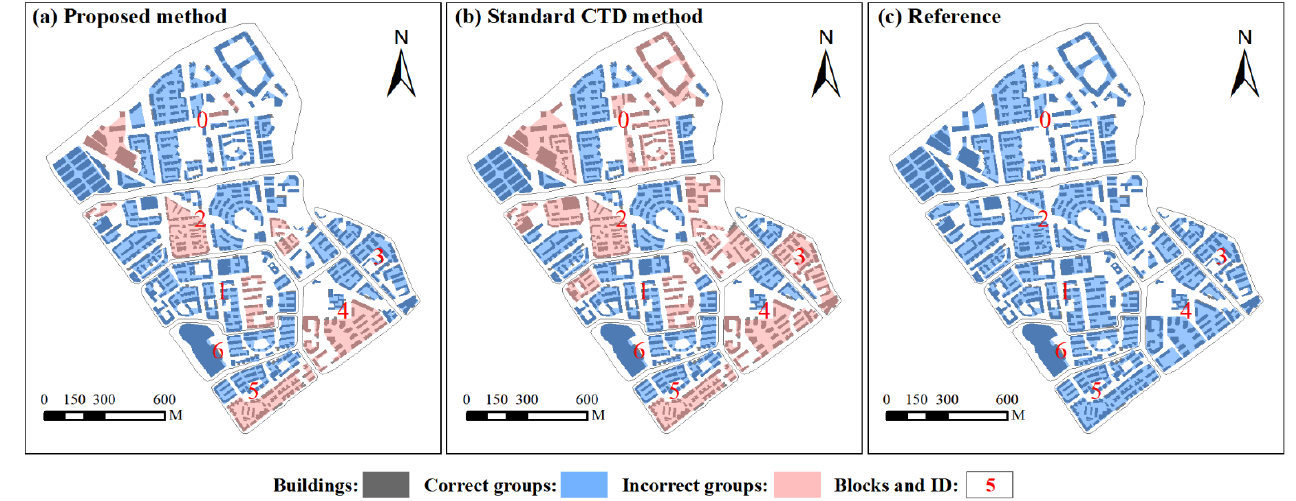
Figure 5. Building group recognition results are shown for ( a ) the proposed method, ( b ) the standard CTD method, and ( c ) the reference map. Buildings covered with blue hatched patterns were correctly grouped, whereas those inconsistent with the reference maps are covered with red hatched patterns. Table 2. The accuracy of building pattern